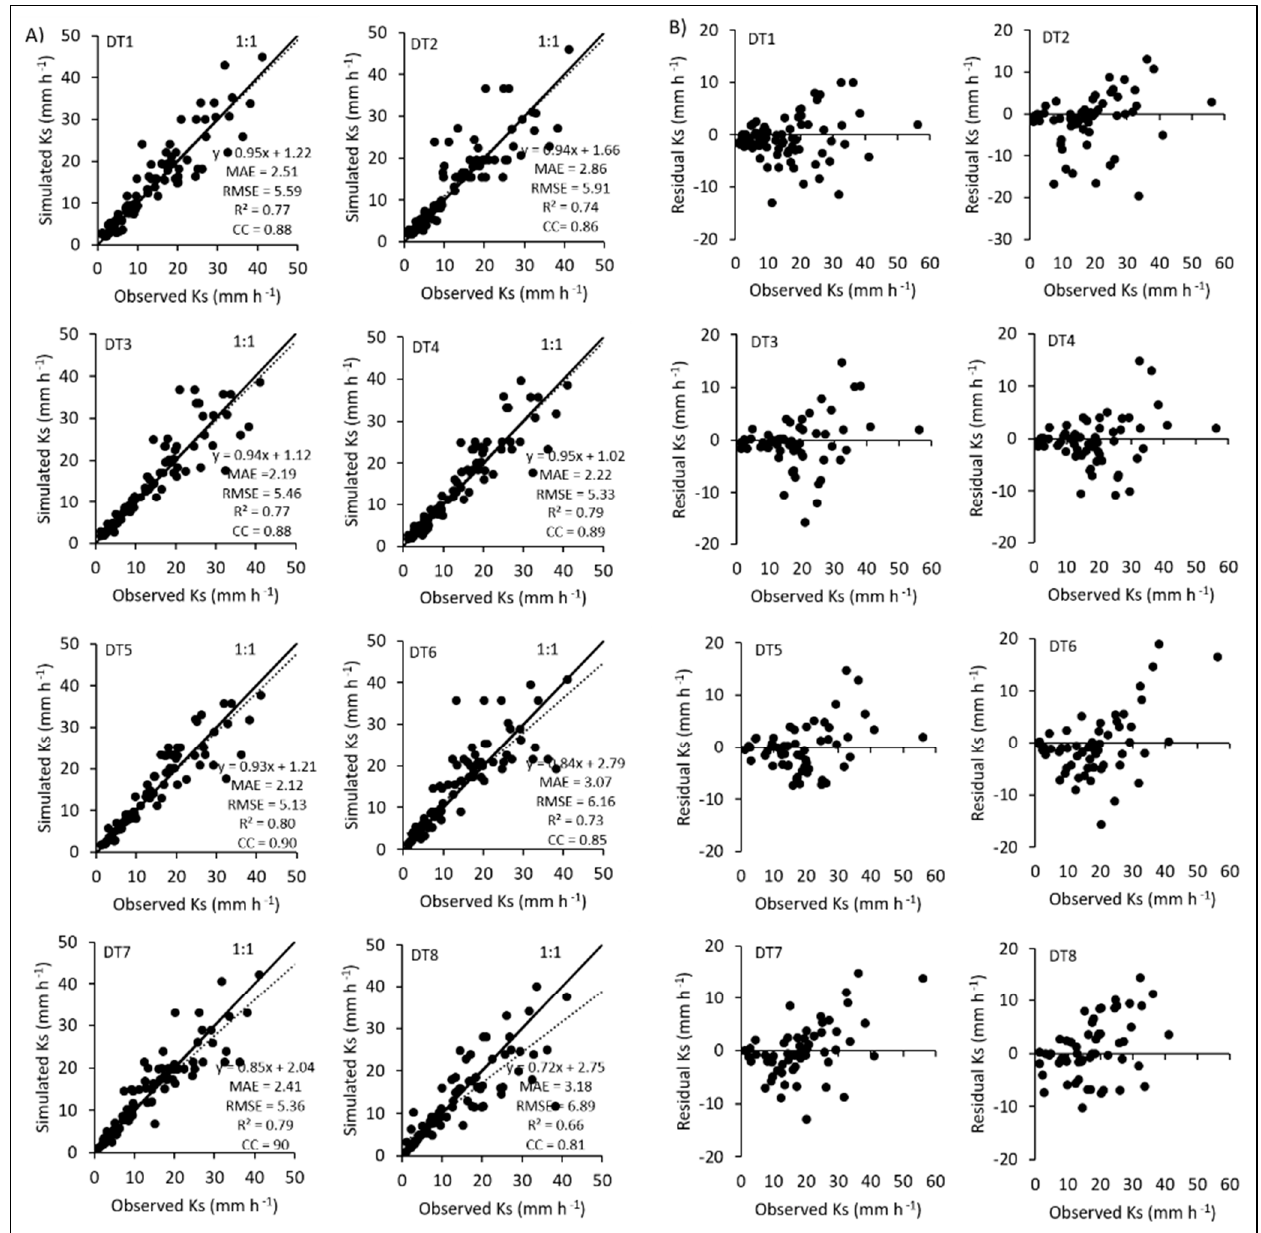
Figure 7. Scatter and residual plots of the DT model with eight combinations of soil input data.